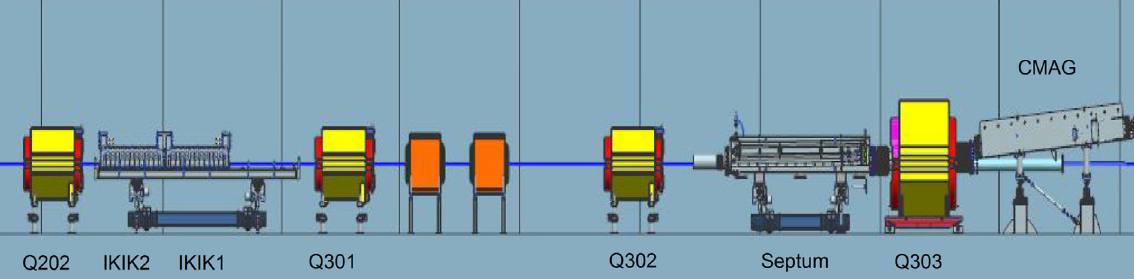
FIG. 2. Conceptual design for injection into the DR, where the beam direction is from right to left. The yellow elements are quads. The two orange objects between quads 302 and 301 are steering dipoles. CMAG is a vertical bending magnet and is the last element of the M3 line.